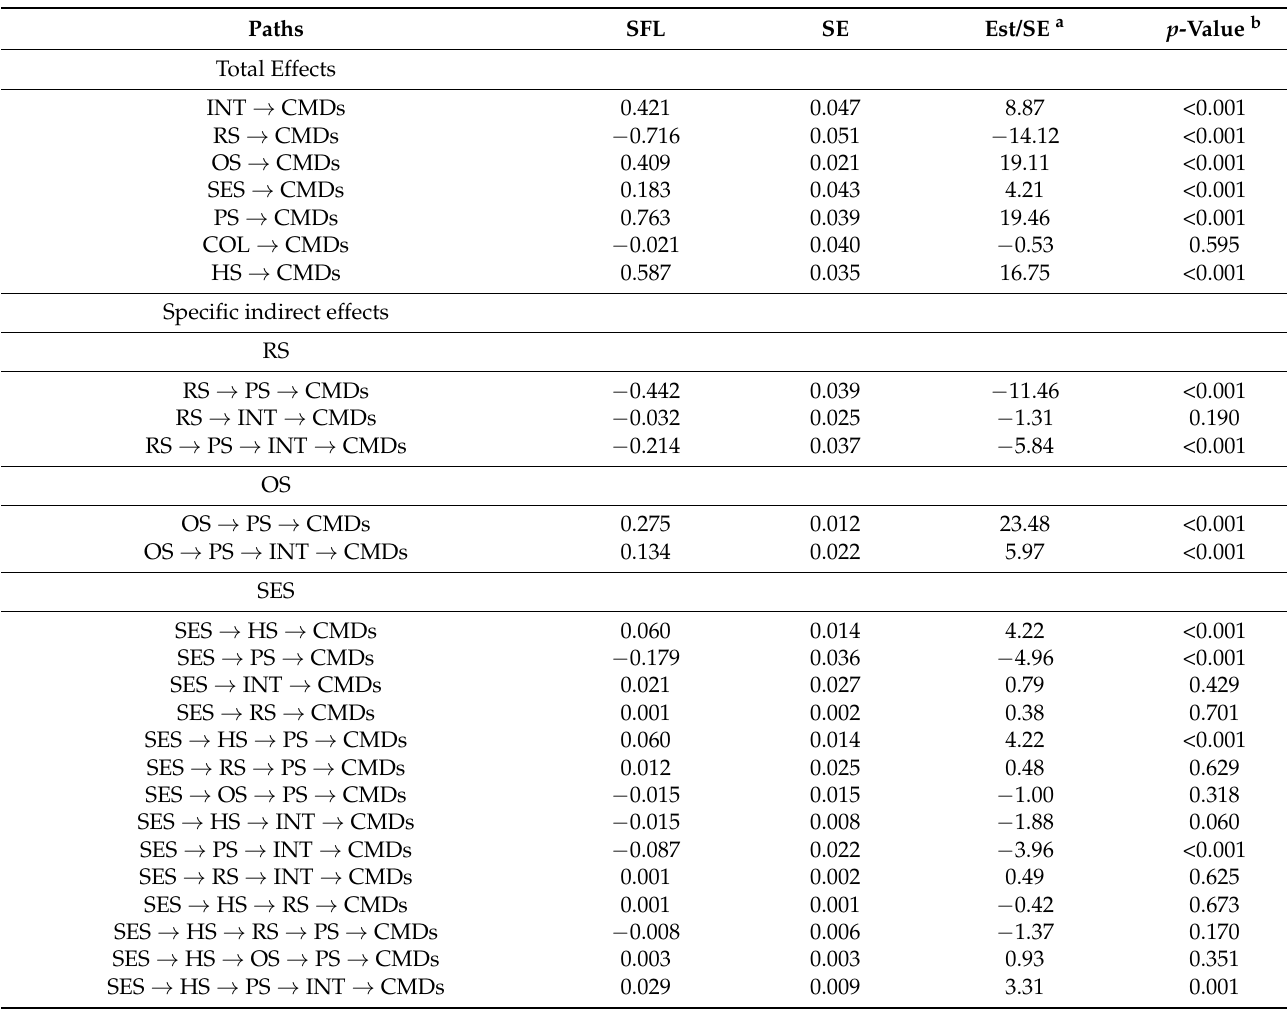
Table 4. Standardized total and indirect effects of the structural equation model, using CMDs as response variable among Brazilian men in the COVID-19 pandemic context. Brazil, 2020. Paths p -Value